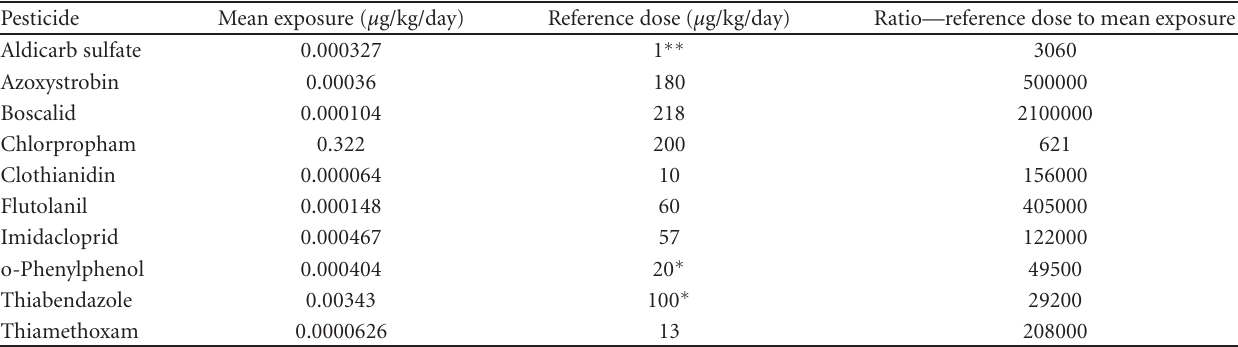
Table 11: Exposure estimates of the ten most frequently detected pesticides on potatoes.